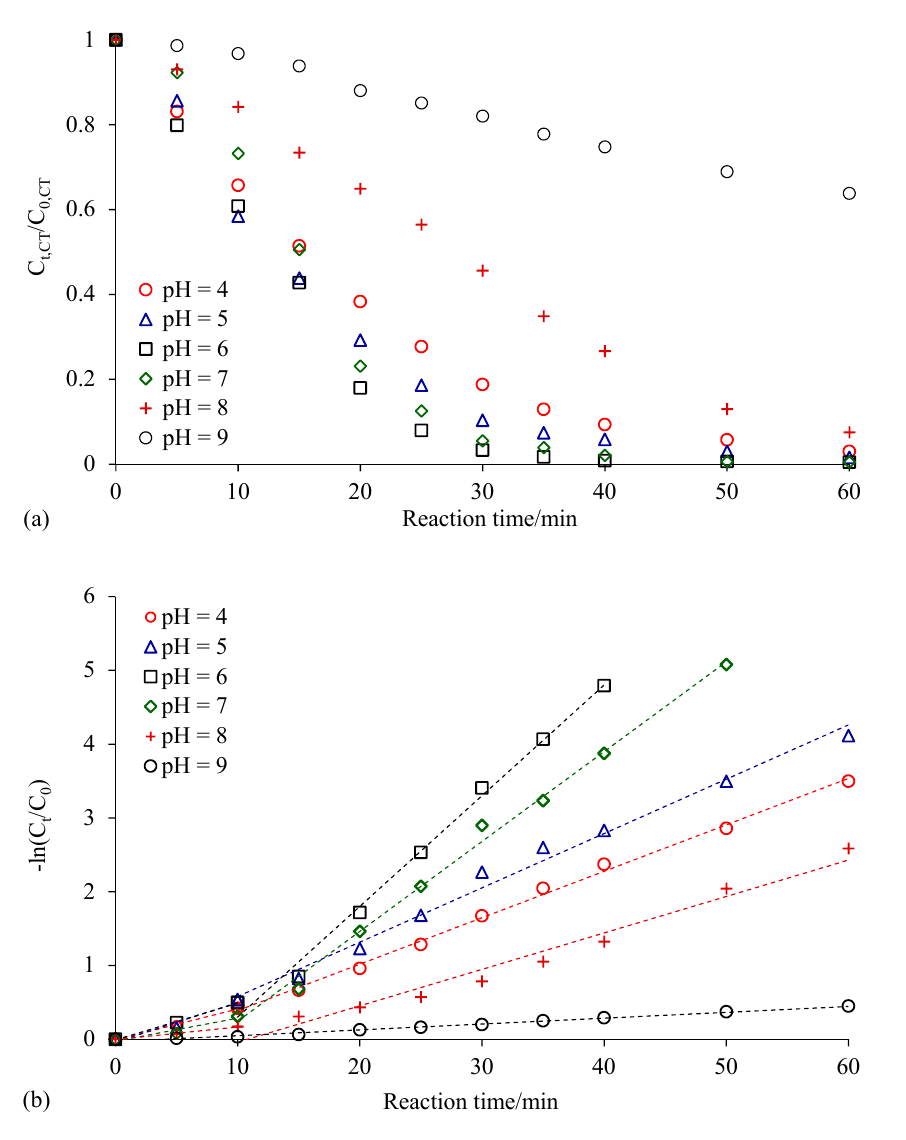
Figure 9. Effect of pH on CCl 4 degradation by Ag/Fe particles. ( a ) Changes in CCl 4 concentration with time; ( b ) kinetics of CCl 4 degradation. Reaction conditions were: initial solution pH of 5, 6, 7 and 8, 0.4 wt.% Ag/Fe dosage of 20 g/L, CCl 4 initial concentration of 20 mg/L, and stirring rate of